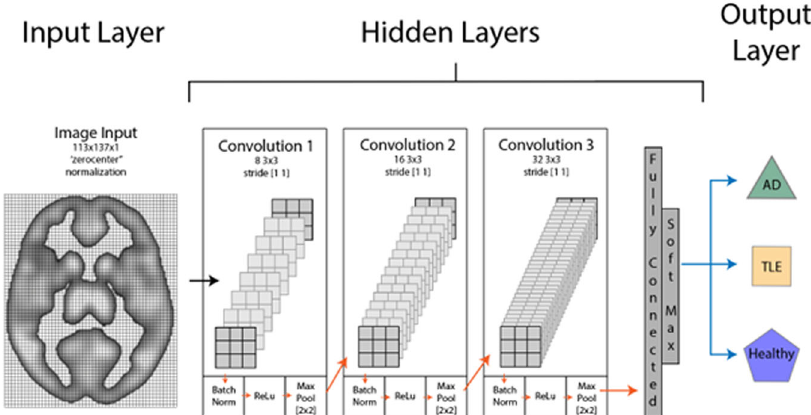
Fig. 4 Convolutional network architecture. Layers are linked in-series with the input layer connected to the hidden layers which is connected to the output layer. Hidden layers are comprised of three convolutional units (convolution, batch norm, ReLu, and max pool) and a classi fi cation layer (fully connected, and